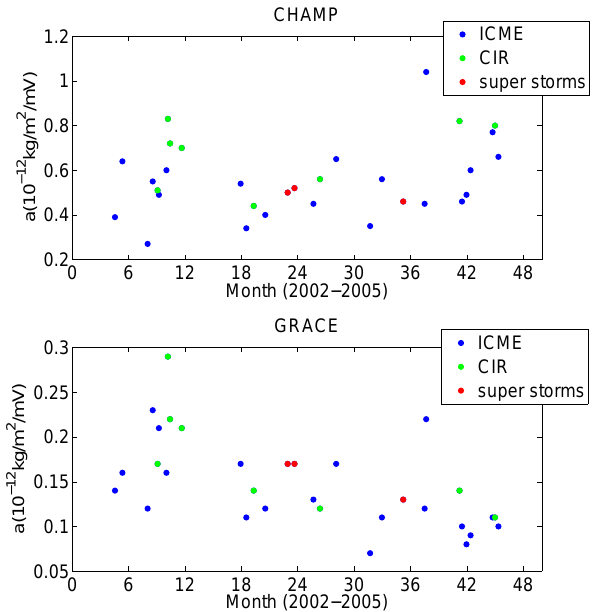
Fig. 4. Temporal evolution of the scaling factor a derived individu- ally for each storm by linear regression between CHAMP (top) and GRACE (bottom) density data and E m during 2002 to 2005. Storm types are identified by color coding: blue for ICME-driven storms, green for CIR driven storms, red for the three super